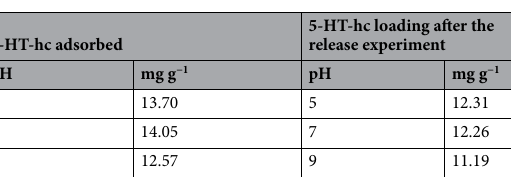
Table 4. 5-HT-hc uptake and release capacities of DETOXSAN at different pH values. Amount of bound 5-HT-hc is averaged between 40 and 120 min after the addition of DETOXSAN for release and uptake studies, respectively. The fixed amine was calculated based on UV Vis data measured in aqueous solutions.